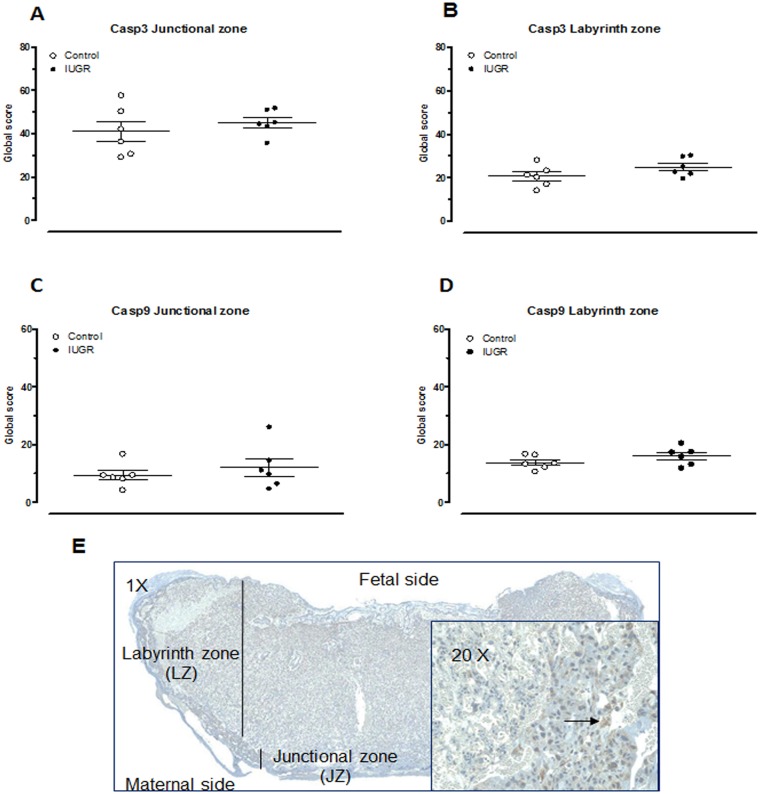
Immunostaining of caspase-3 (A, B) and -9 (C, D) in placenta from control and IUGR 22-day pregnant rats.Quantification of caspase 3 (cleaved) and 9 expression in the junctional (A, C) and labyrinth (B, D) zones. Each point represents one placenta. Global Score = (MI x Area)LOW + (MI x Area)MOD + (MI x Area)STRONG / Total Area of ROI (see Methods). (n = 6 rats/group). Representative immunostaining of cleaved caspase-3 from placenta of control rats (E). Inset: Arrow indicates brown positive stains.